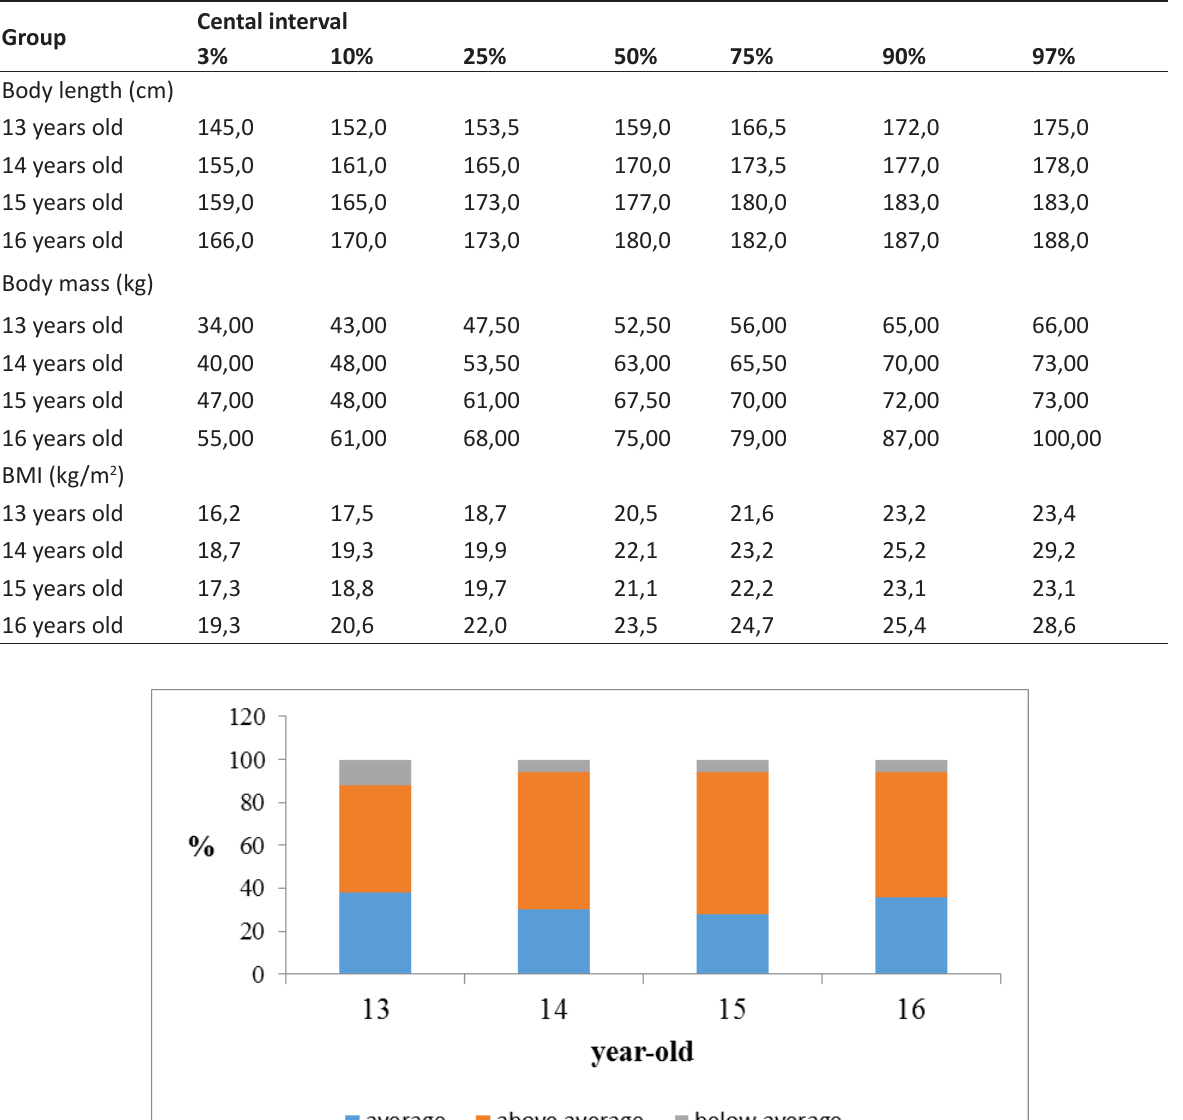
Table 2. Cental tables of distribution of length and body weight of hockey players from 13 years to 16 years Cental interval Group